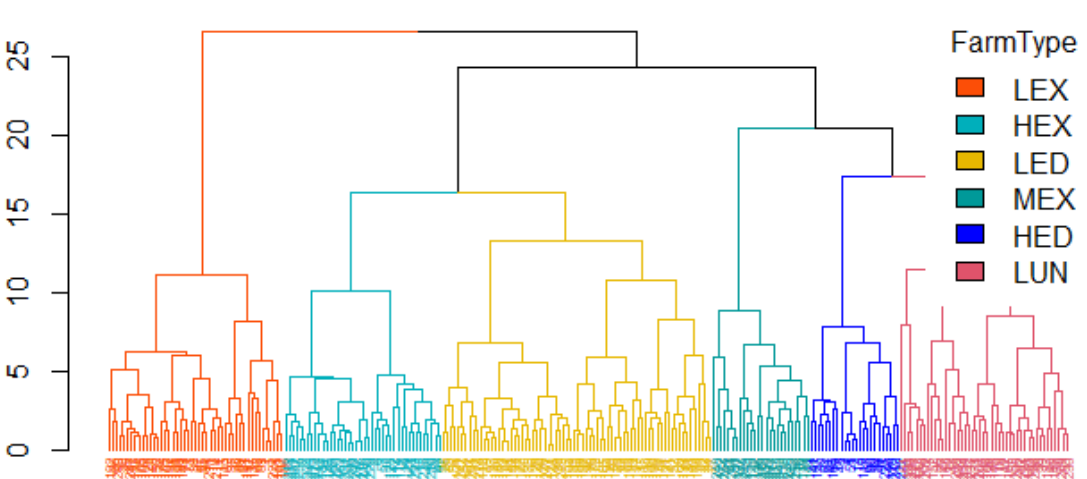
Figure 3. Representation of the six farm types constructed resulting from hierarchical clustering using the Ward’s method. Farm types and their size were: LEX (low-resourced and experienced— 47), HEX (high-resourced and experienced—24), LED (low-resourced and educated—42), MEX (me- dium-resourced and experienced—45), HED (high-resourced and educated—26), LUN (low-re- sourced and inexperienced—72), respectively .